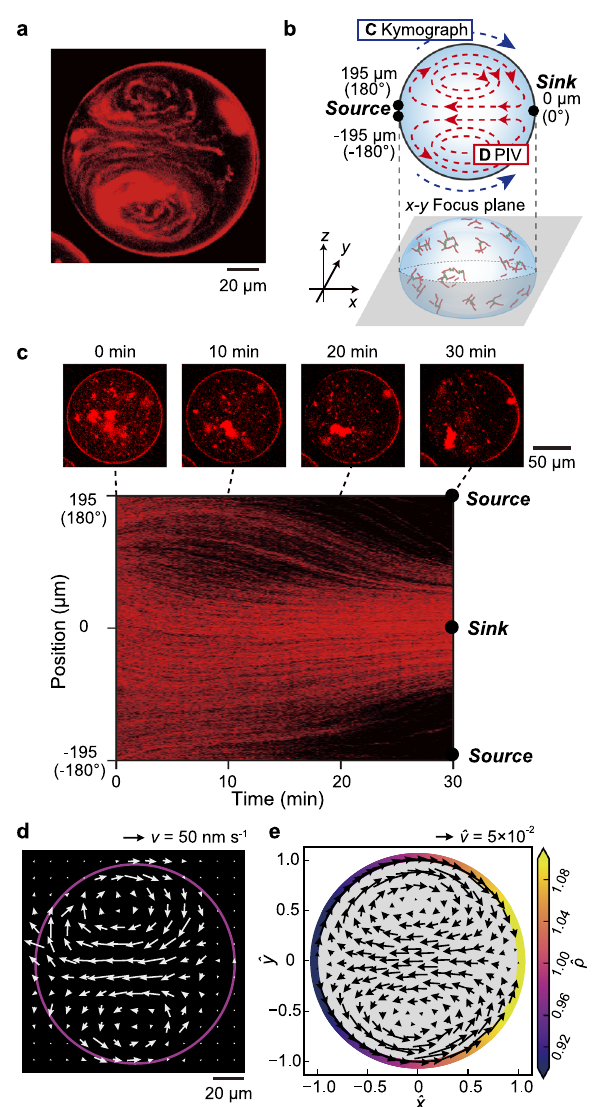
Fig. 2 Analysis of active vortices inside a droplet upon the addition of ATP. a MT labelled with ATTO647N is visualized at the middle part along the dorsoventral axis of the droplet. Addition of ATP to the system promotes the aggregation of MT, indicating the formation of an aster-like structure. Furthermore, active fl ow is generated at the interface, where MT and kinesin are accumulated to form an arti fi cial cortex (Supplementary Movie S2). b Schematic illustration of droplet geometry and the coordinate system. c , Snapshots of the droplet every 10 min and kymograph analysis of the droplet interface. The fl uorescently labelled MT and kinesin (aster-kinesin complex) gradually accumulated at the sink. d Flow fi eld inside of a droplet obtained using the PIV method. While intensive fl ow is generated inside the droplet, accumulation of the arti fi cial cortex was noted. The fl ow is directed source-to-sink at the interface, while back fl ow is noted at the middle. The double roll is clearly visualised and the fl ow speed is typically ~130 nm s − 1 (7800 nm min − 1 ), which is comparable to the speed of the accumulation of the aster-kinesin complex. e Numerical result of vortex fl ow pro fi le at a ^ t = 2000 obtained using Eqs. (1 – 3) with experimentally plausible values. The colour indicates the MT surface density, while ρ indicates the density gradient formation. Details of the numerical simulation as well as the estimation of parameters are given in the Method